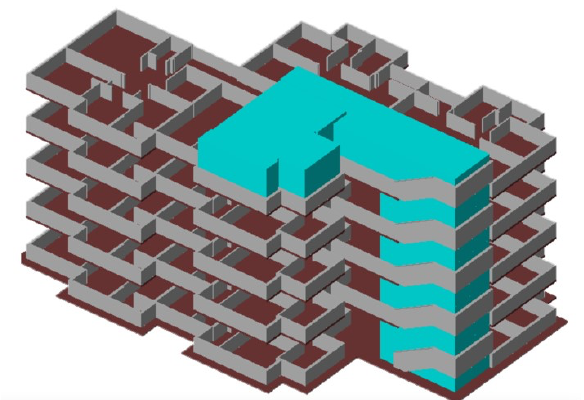
Figure 16. Legal right of Unit 5 4th floor (method 1)